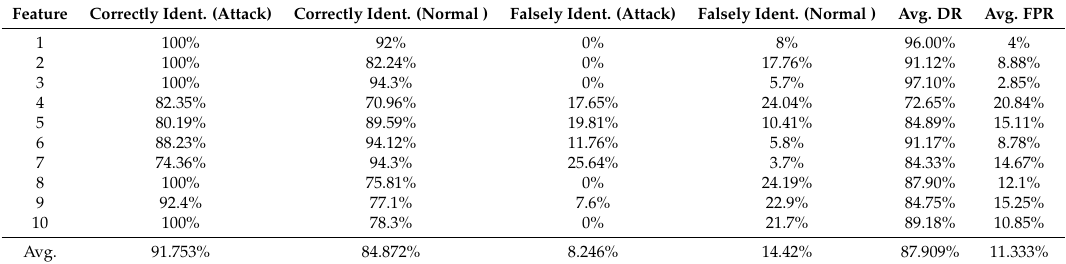
Table 3. Performance of features using One Class SVM on features in Table 2.